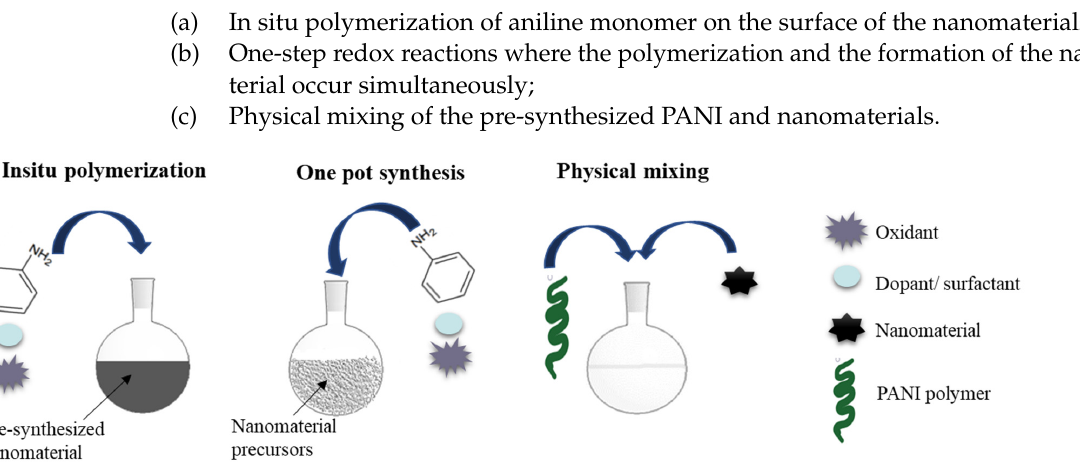
Figure 4. SEM images of different structures of PANI polymer: ( a ) 3D hierarchical PANI [28], ( b ) nanowire [29], ( c ) nanoflowers [30], ( d ) nanorods [31], ( e ) microspheres [32], ( f ) nanotubes [33].